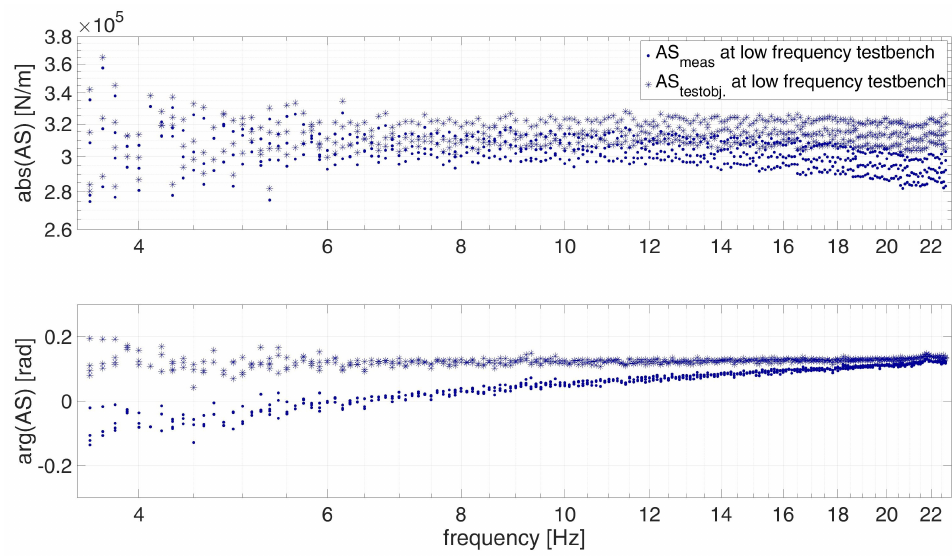
Figure 10. Apparent Stiffness directly measured AS meas . and calibrated AS testobj . of the compliant element A at the low frequency test